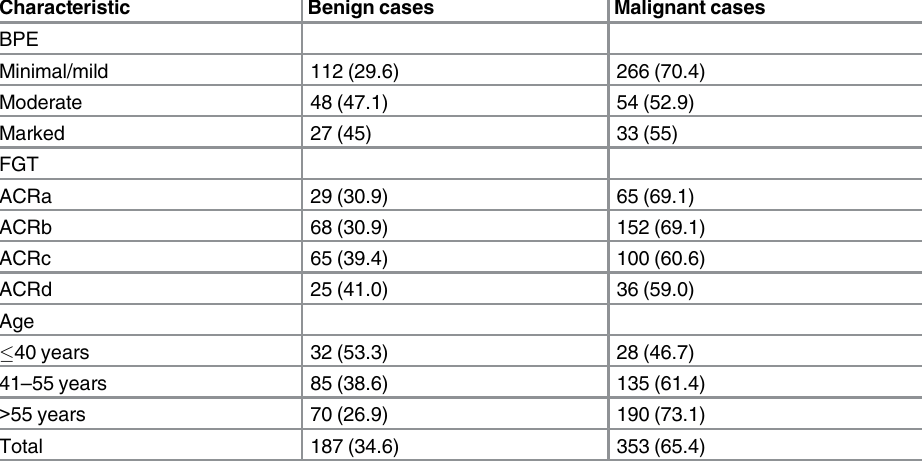
Table 1. Comparison of imaging characteristics between benign and malignant findings. Characteristic Benign cases Malignant